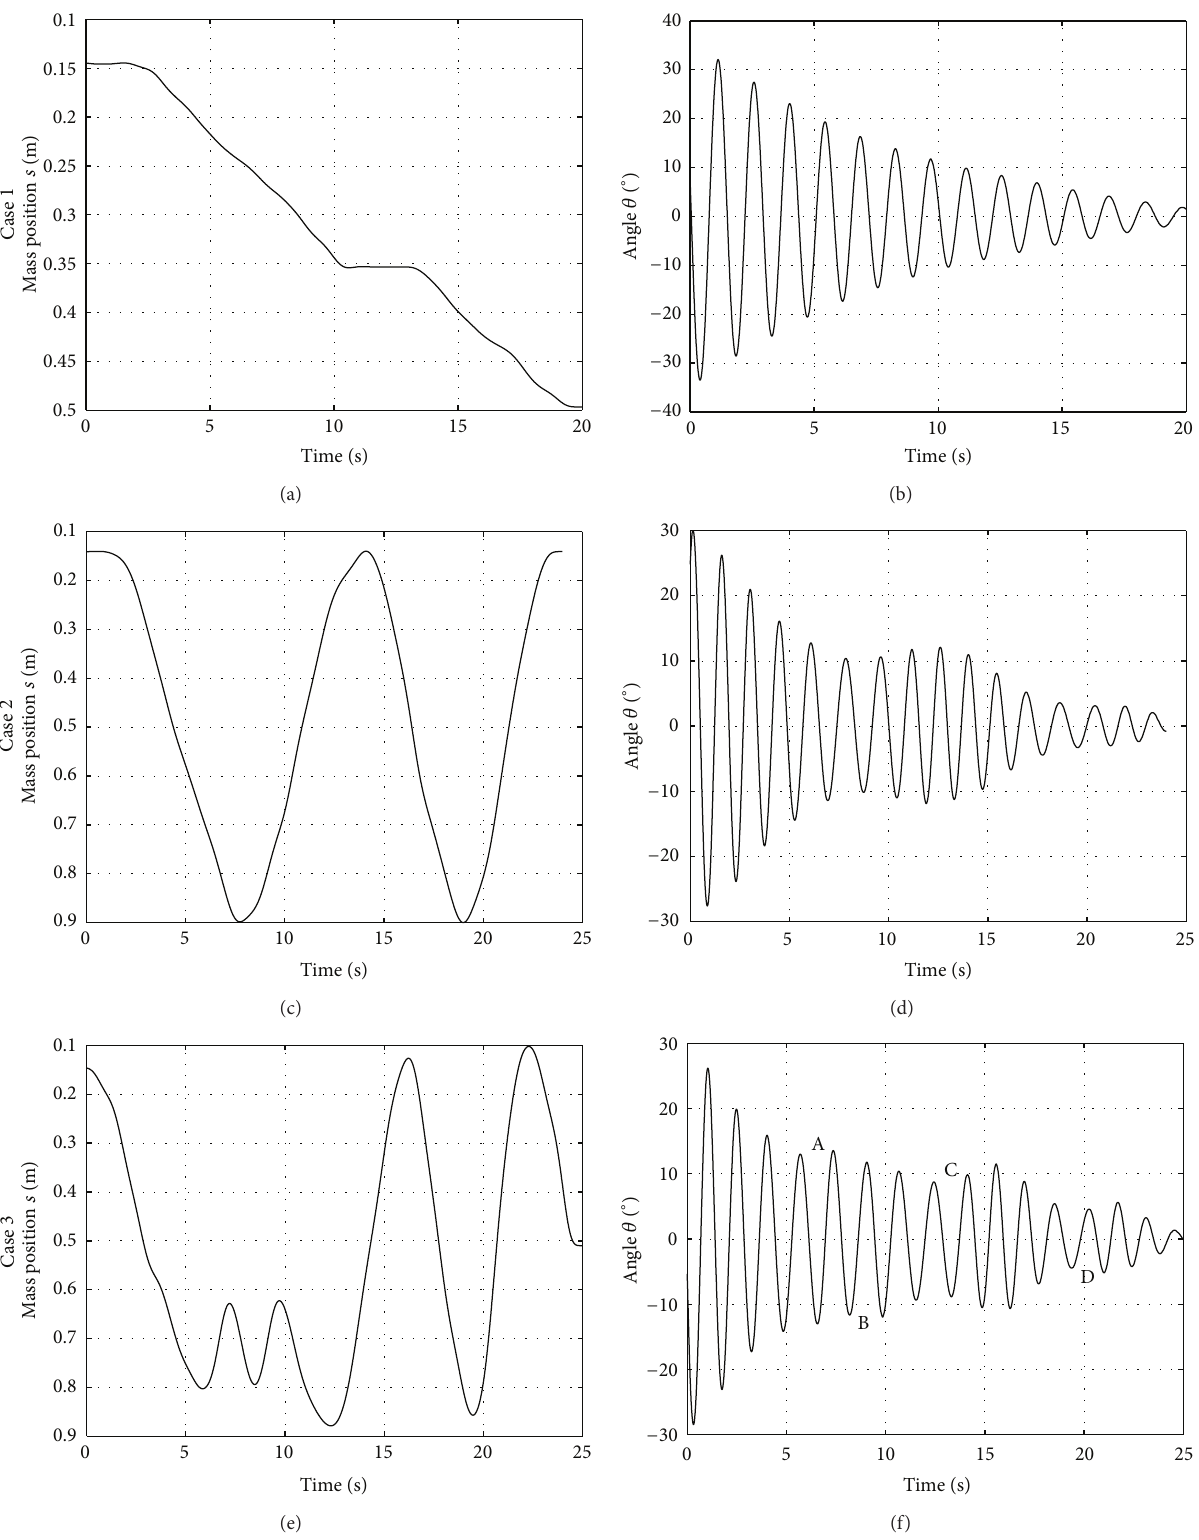
Figure 5: Moving mass. (a, b) Case 1. (c, d) Case 2. (e, f) Case 3. (a, c, e) Mass position along the beam. (b, d, f) Swinging amplitude over